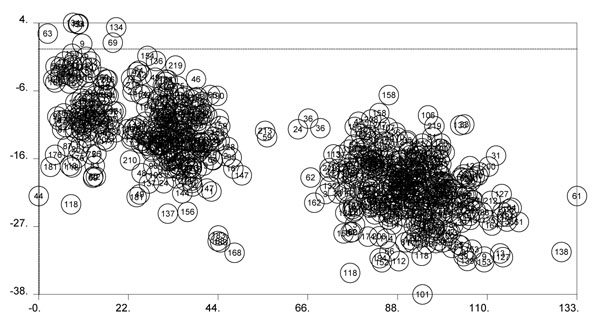
Framingham study of hypertension: orthogonal projection onto cluster centers 1/2/3 Structural decomposition of genetic diversity: projection of the feature vectors of 1328 subjects onto the plane defined by the three largest cluster centers.